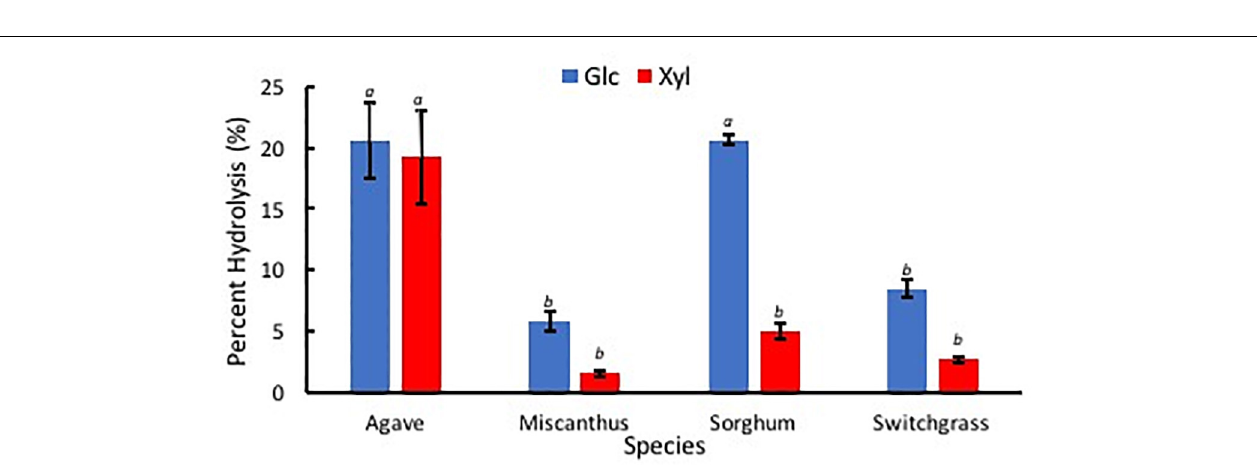
FIGURE 9 | Percent sugars Glc (blue) and Xyl (red) released from low solids loading enzymatic hydrolysis for each of the four species A. americana (Agave), miscanthus, sorghum, and switchgrass. Error bars indicate standard error; n = 3. Lowercase italic letters indicate significant differences between species by sugar type as per Tukey’s HSD test ( p <